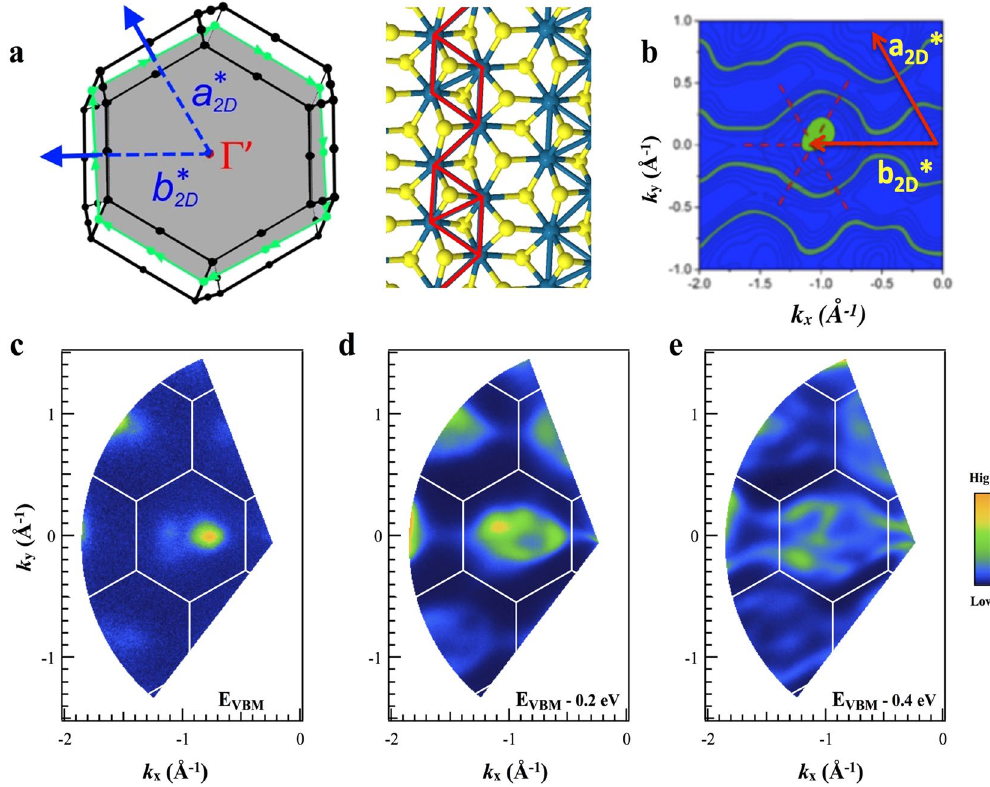
Figure 2. ARPES maps of photoemission intensity as a function of in-plane wavevector ( a ) View along the c * axis of the first Brillouin zone, showing the irregular hexagon (gray) defined by ⁎ a single ReSe 2 layer indicating the orientation of the chains with respect to the Brillouin zone. ( b ) A theoretical contour plot at 0.4 eV below the valence band maximum. The dotted cross indicates the position of a Γ ’ point. For comparison, in Figure S1 of the supplementary information all experimental contour plots are compared with the corresponding theoretical ones. ( c–e ) Experimental maps ( c ) near the valence band maximum (VBM); ( d ) 0.2 eV below the VBM and ( e ) 0.4 eV below the